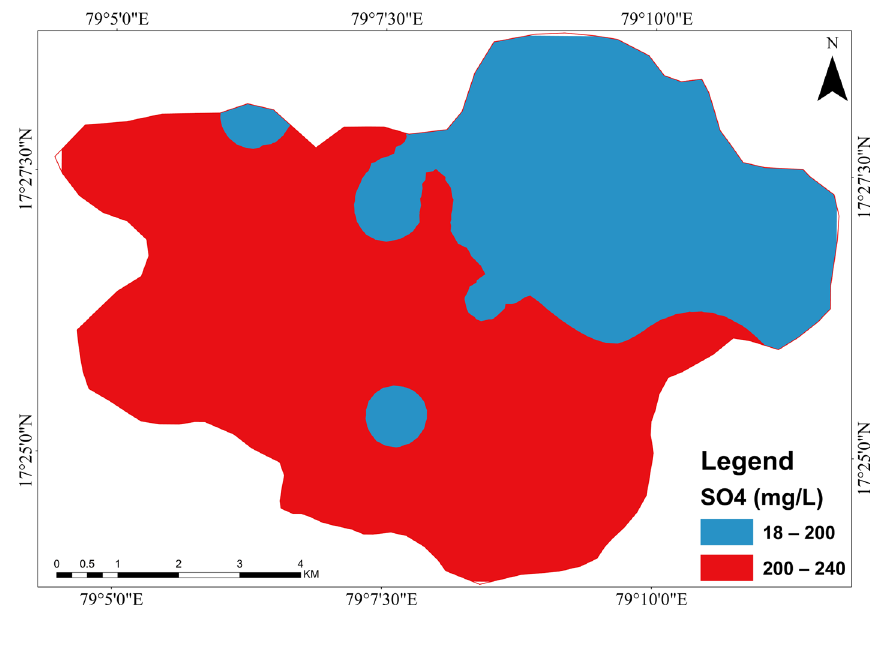
Fig. 12 Spatial distribution map of Cl − in Mothkur